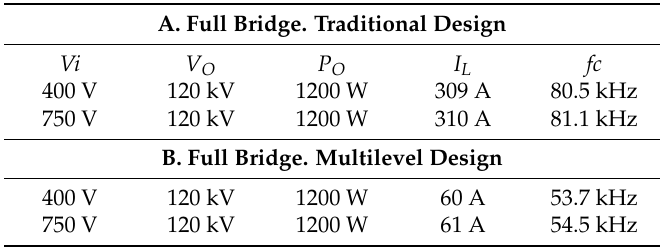
Figure 8. Resonant circuit for radioscopy and fluoroscopy.